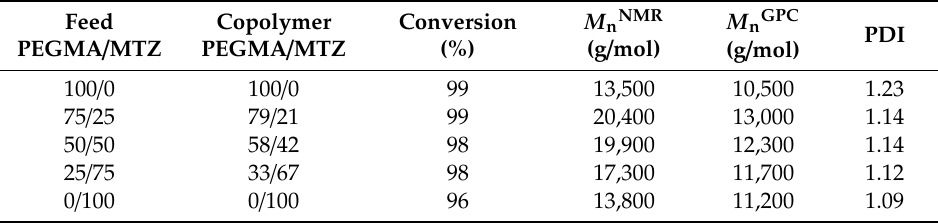
Figure 1. ( a ) 1 H and ( b ) 13 C nuclear magnetic resonance (NMR) spectra of the copolymer with a PEGMA / MTZ ratio of 50 / 50. Table 1. Molecular parameters of the synthesized polymers: copolymer composition poly(ethylene glycol) methyl ether methacrylate (PEGMA) / 2-(((2-(4-methylthiazol-5-yl)ethoxy)carbonyl)oxy)ethyl methacrylate monomer (MTZ), conversion, number average molecular weight ( M n ) determined by nuclear magnetic resonance (NMR) and gel permeation chromatography (GPC), and polydispersity index (PDI) determined by GPC.